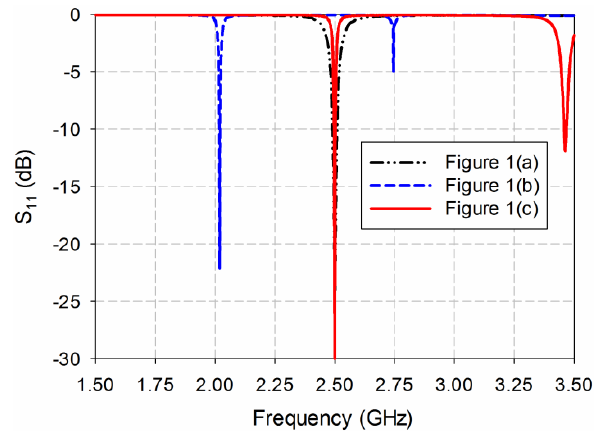
11 ) of the three antennas in Figure